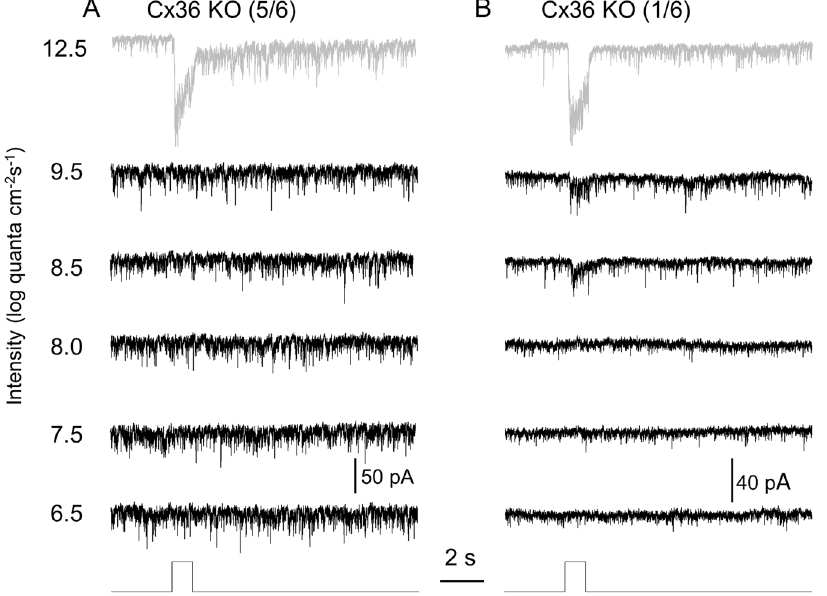
Figure 4. Rod-mediated DAC responses are eliminated or reduced in Cx36 KO mice. Six DACs were recorded in Cx36 KO retinae. ( A ) Five out of six DACs had no responses to a series of increasingly white light pulses (1-s duration) ranging from 6.5 to 9.5 log quanta/cm 2 /s (black traces). Top trace (gray) shows that the cell